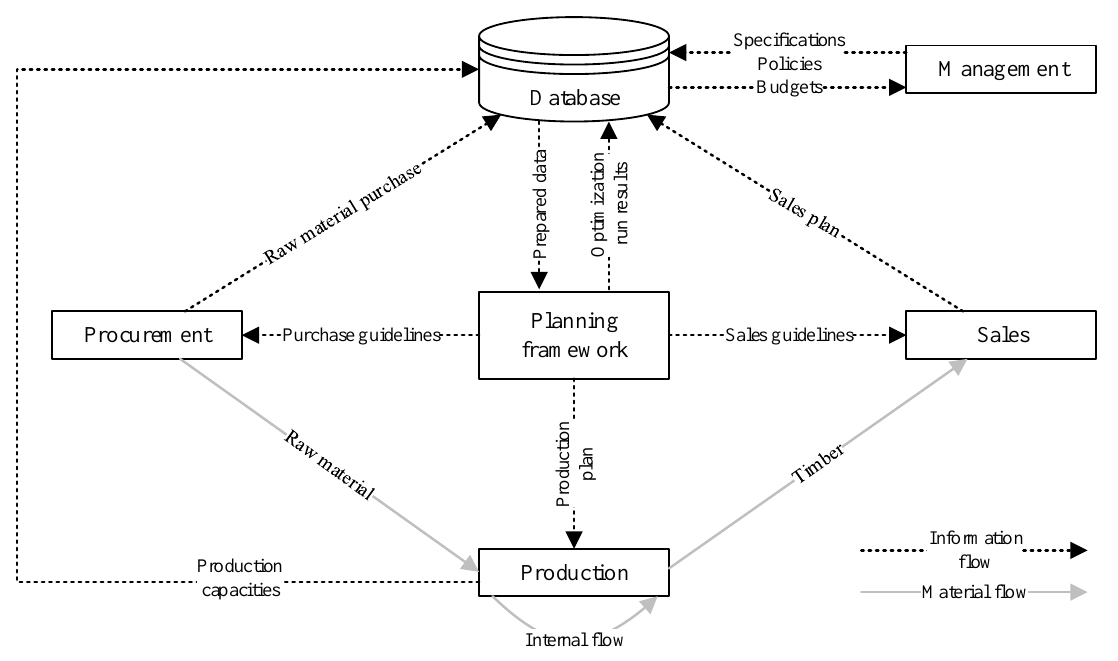
Figure 4. General overview of interaction and information exchange between the individual departments included in the iterative planning process, as presented in Figure 3.